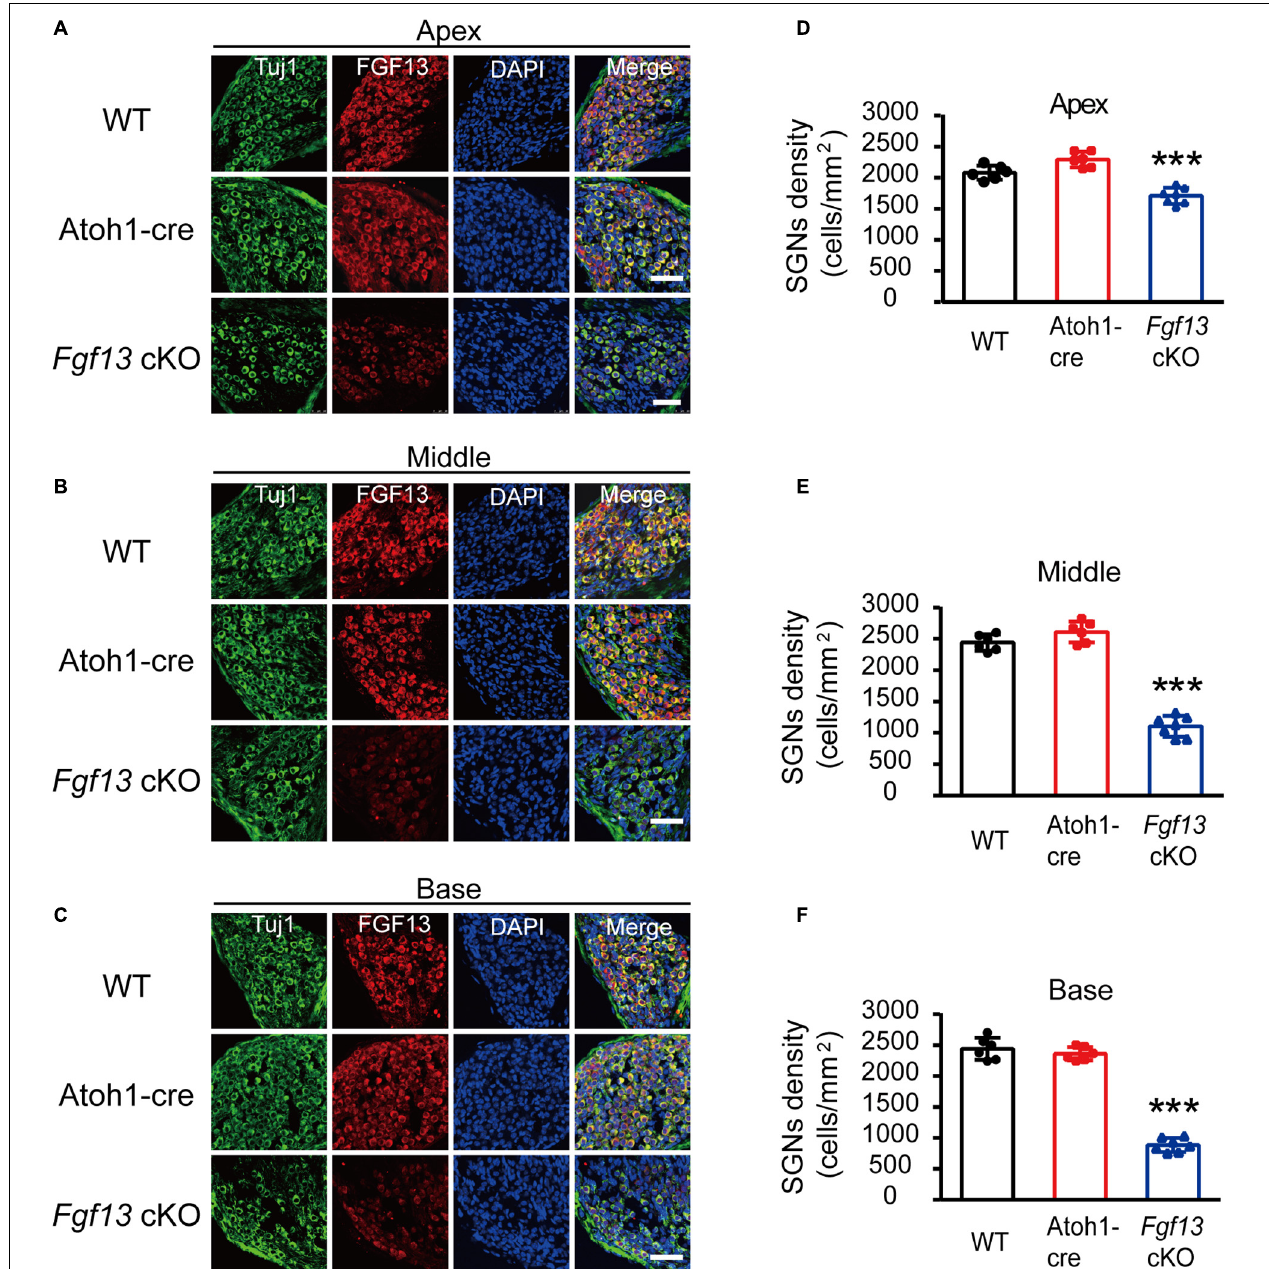
FIGURE 4 | Reduced SGN density in Fgf13 cKO mice. (A–C) Immunostaining of FGF13 in SGNs marked by Tuj1 from apex (A) , middle (B) , and base (C) in WT, Atoh1-cre and Fgf13 cKO mice. Scale bar = 50 µ m. (D–F) Quantitative assessment of SGNs densities from the apex to the base. n = 6/WT (5 M, 1 F); n = 6/Atoh1-cre (4 M, 2 F); n = 7/ Fgf13 cKO (5 M, 2 F). F, female; M, male. *** P < 0.001 compared to controls as determined by One-Way